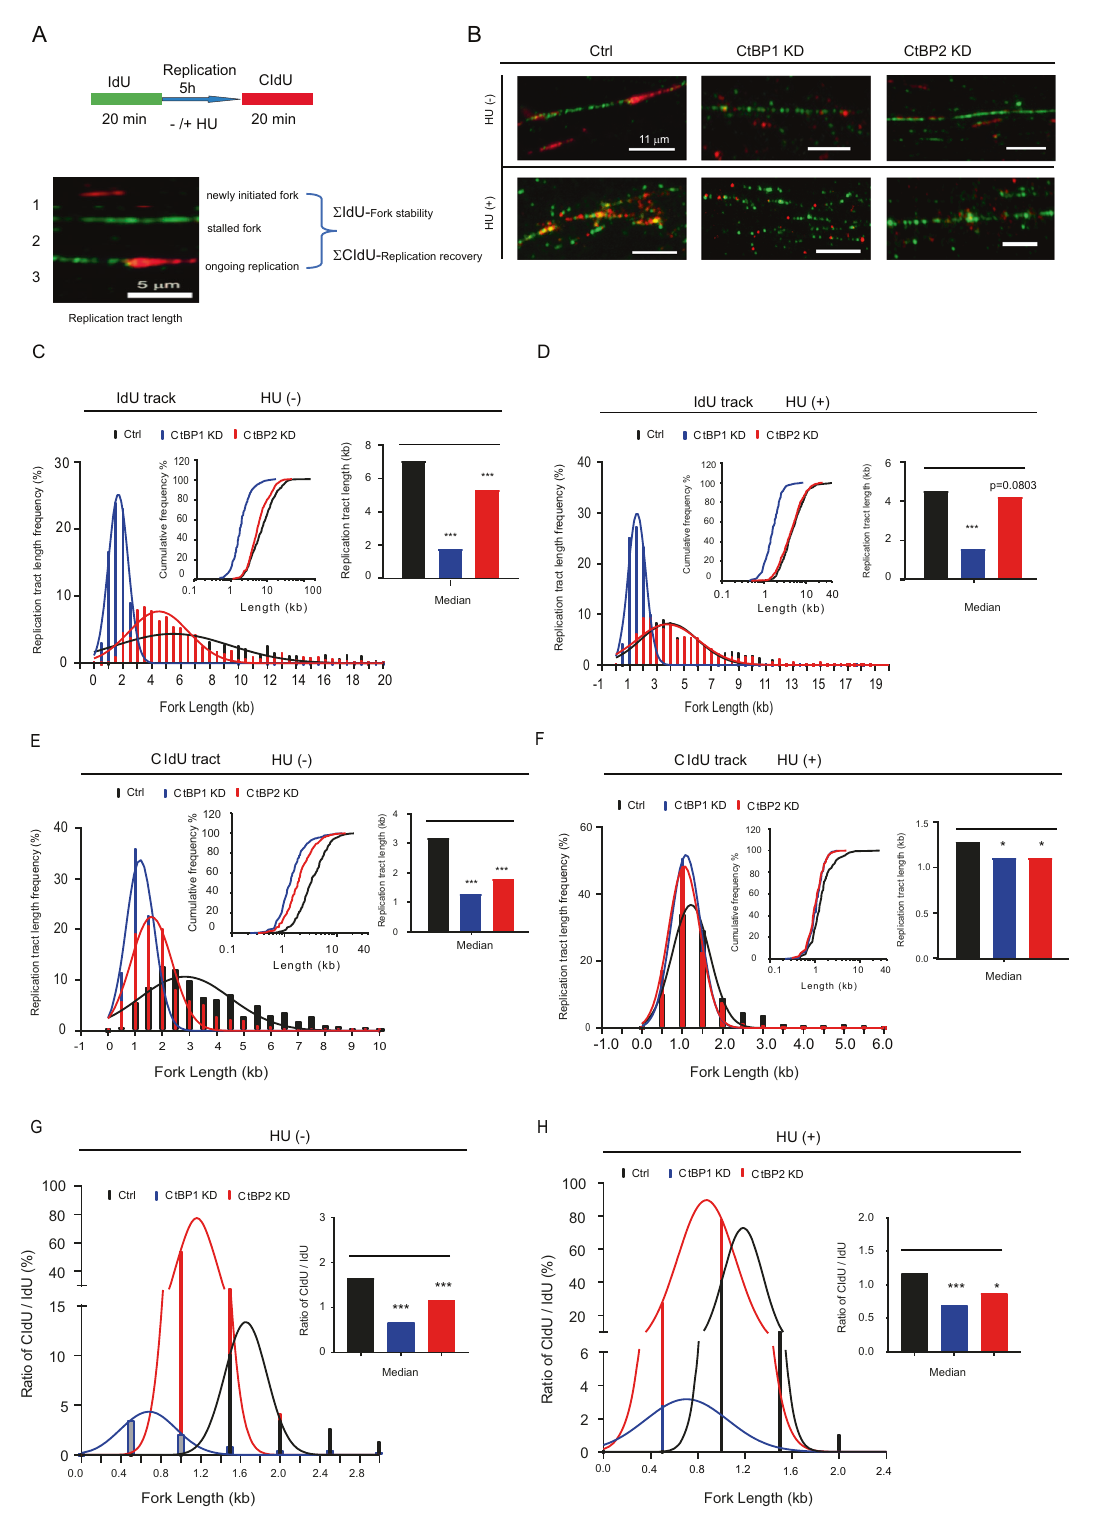
genomic stability, and cell survival [26]. Under rest conditions (without any treatment), the γ H2AX phosphorylation foci number per cell was signi fi cantly increased in CtBP1-KD and CtBP2-KD cells (Fig. 3D, E). The RPA32 phosphorylation foci signal was almost negative in these cells, with no statistically signi fi cant difference (Fig. 3F). The intensity of γ H2AX and RPA32 phosphorylation